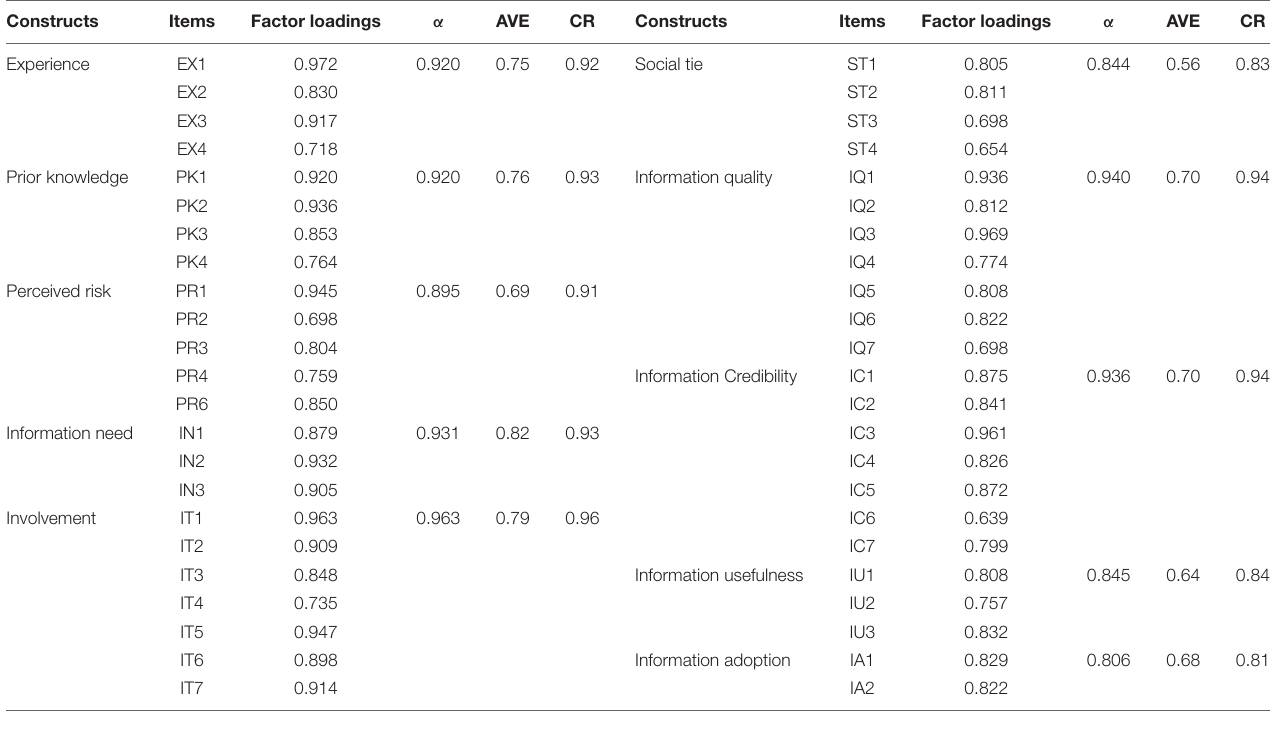
TABLE 2 | Confirmatory factor analysis, Cronbach’s alpha, average variance extracted, and composite reliability ( n = 390). Constructs